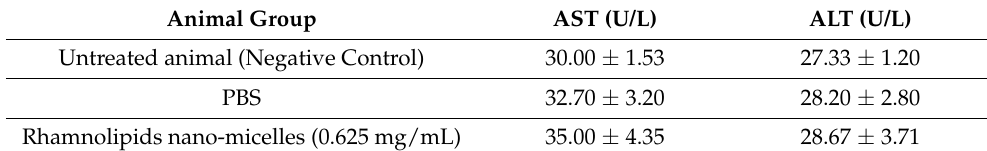
Table 4. * Effect of tested solutions, rhamnolipids nano-micelles and PBS (10 mM, pH 7.4) on serum biochemical markers. Data are presented as an average ± SE, results are average of three replicates.